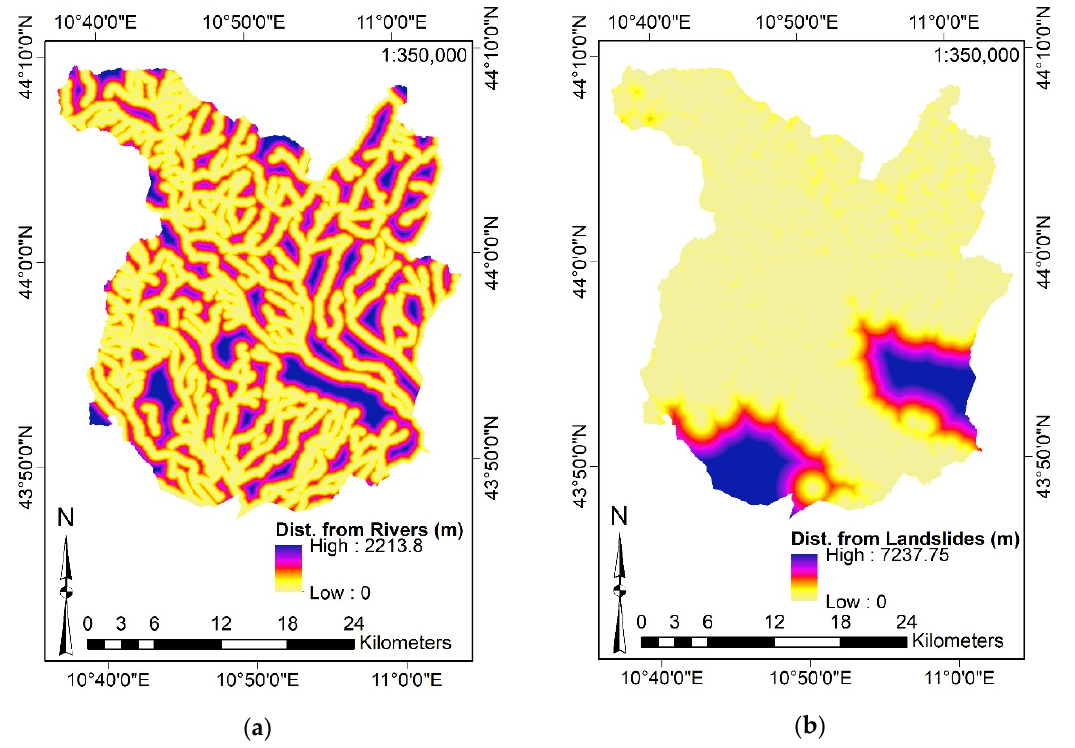
Figure A8. Input features—Euclidean distances: ( a ) Distance from rivers; ( b ) Distance from Landslides.